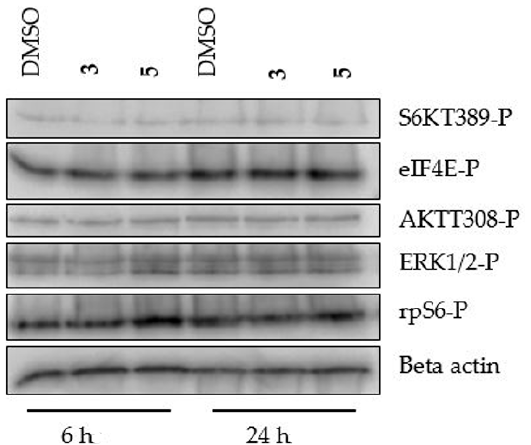
Figure 6. Representative Western blot analysis of both 3 - and 5 -treated MDA-MB-231 cells from three independent experiments ( n = 3). Western blot analysis showing the effect of 5 µM of 3 and 5 on various signalling molecules after 6 h and 24 h incubation. MDA-MB-231 cells were incubated with DMSO alone (lanes 1 and 4), 3 (lanes 2 and 5) or with 5 (lanes 3 and 6). Cellular lysates were prepared and immunoblotting was performed using 20 µg of total lysate protein, as described in the Materials and Methods.